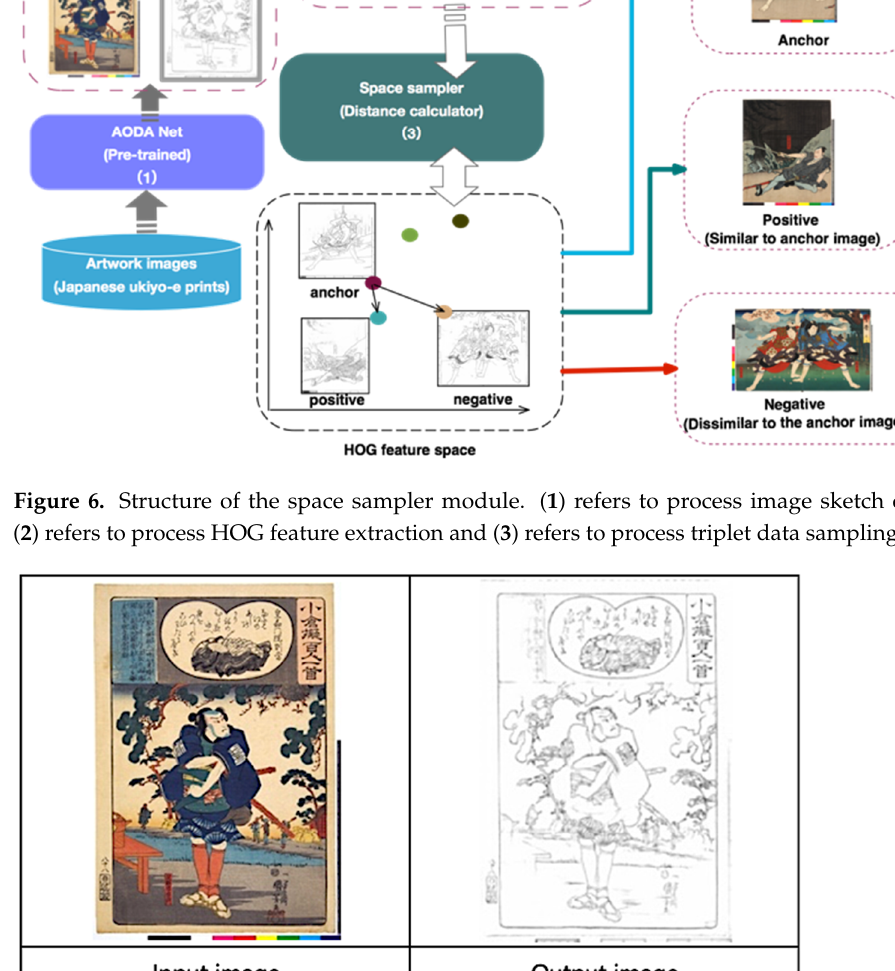
Figure 6. Structure of the space sampler module. ( 1 ) refers to process image sketch extraction, ( 2 ) refers to process HOG feature extraction and ( 3 ) refers to process triplet data sampling.